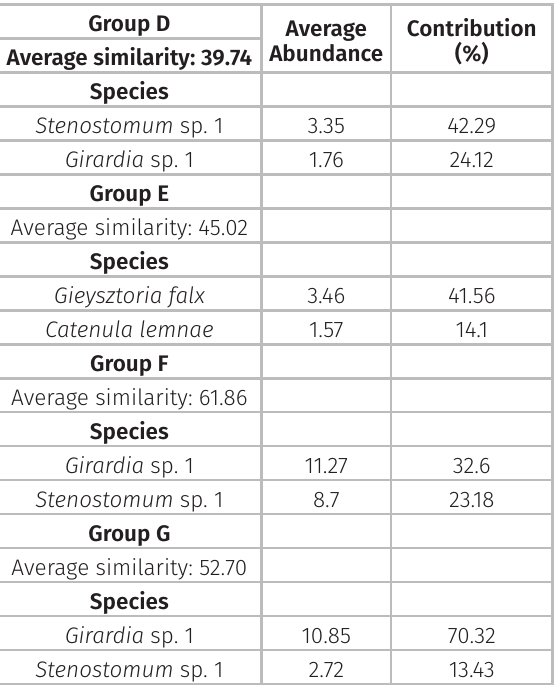
Table IV. Percentage contribution of typifying taxa to within-group similarity for the identified turbellarian assemblages by cluster analysis (cut off for low contributions: 90%). The first two species with the greatest contribution are